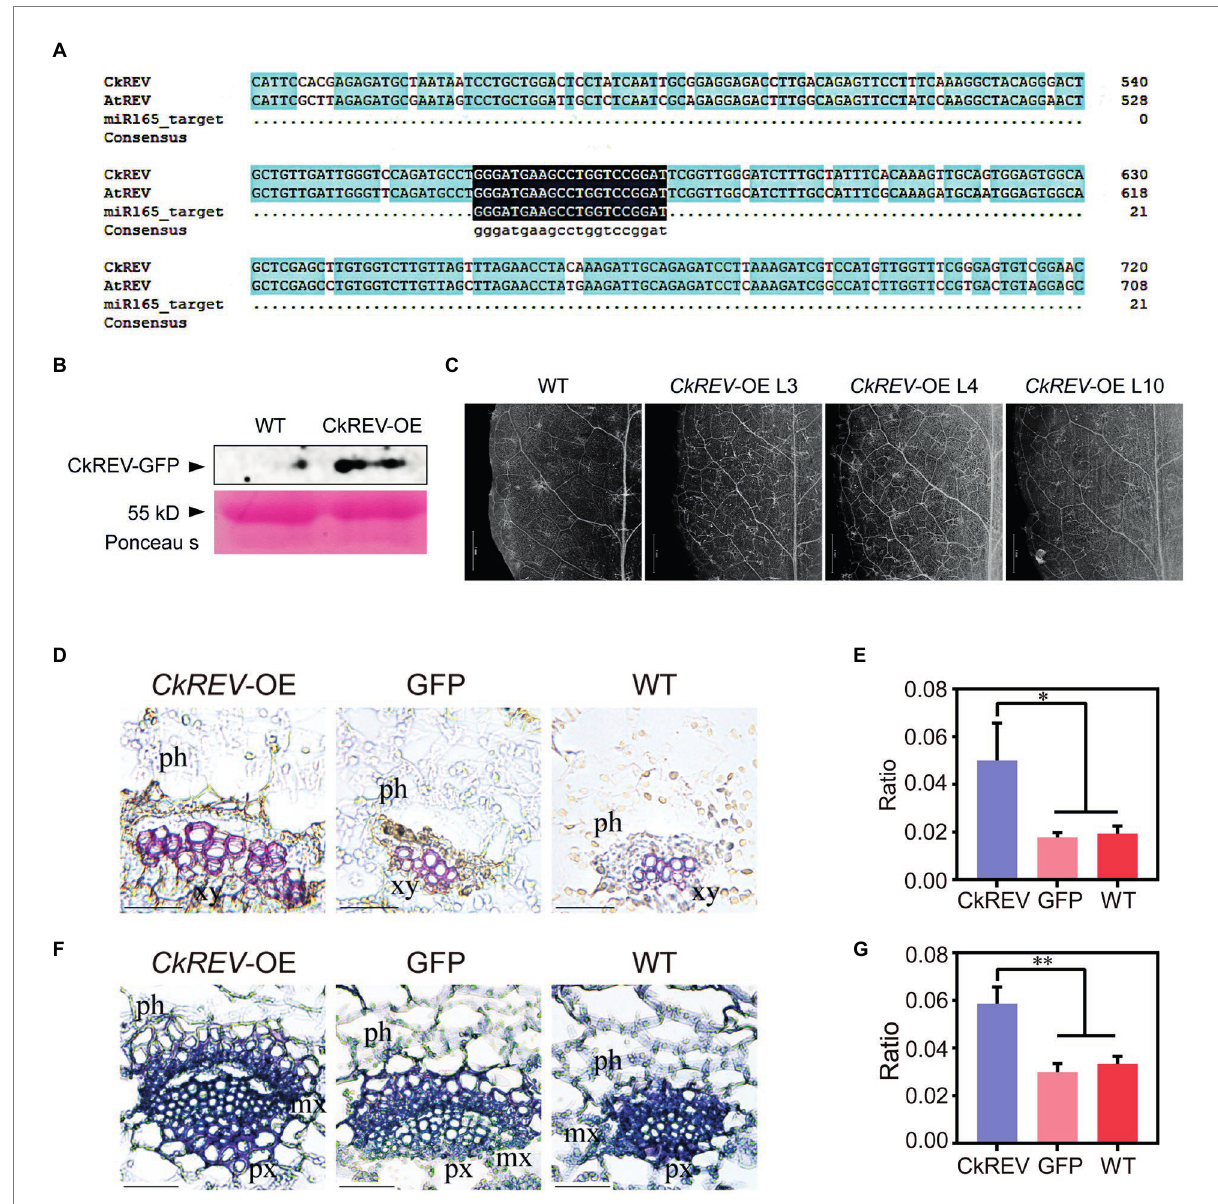
FIGURE 2 CkREV facilitates more well-developed conducting tissue in Arabidopsis thaliana. (A) Sequence alignment. (B) Detection of CkREV proteisn expression. (C) Observation of vein density of A. thaliana CkREV -OE lines. Scale bar = 1 mm. (D,E) Safranin staining of vein sections of A. thaliana CkREV -OE lines (D) and the ratio of stained xylem region to the entire vascular bundle (E) . ph, phloem; xy, xylem. (F,G) Toluidine blue staining of vein sections of A. thaliana CkREV -OE lines (F) and the ratio of stained xylem region to the entire vascular bundle (G) . ph, phloem, px, protoxylem, mx, metaxylem. Error bars indicate SD ( n = 3). (E,G) Student’s t -test is employed to measure statistical significance between two samples with confidence level at 0.95 ( * p < 0.05; ** p < 0.01). Scale bars in (D,F) = 50 μ